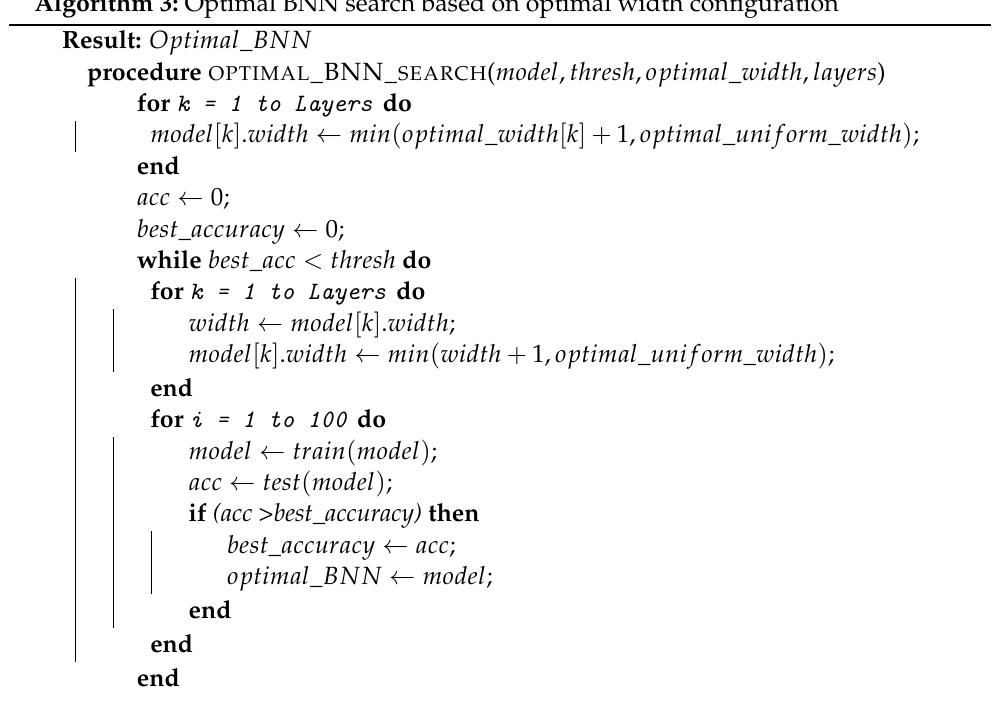
Algorithm 3: Optimal BNN search based on optimal width configuration